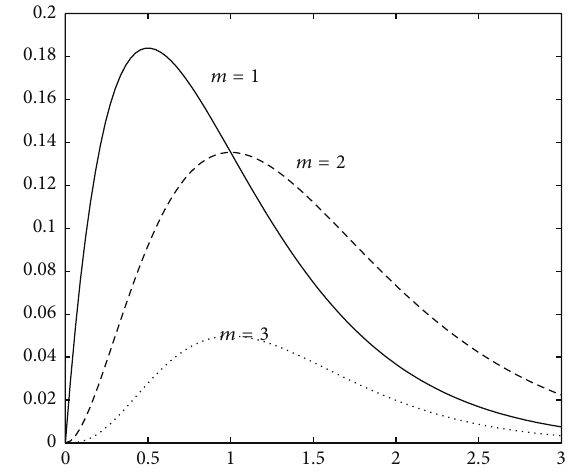
Figure 1: Graphs of the birth rate 𝛽(𝜔,𝑚) for different values of 𝑚